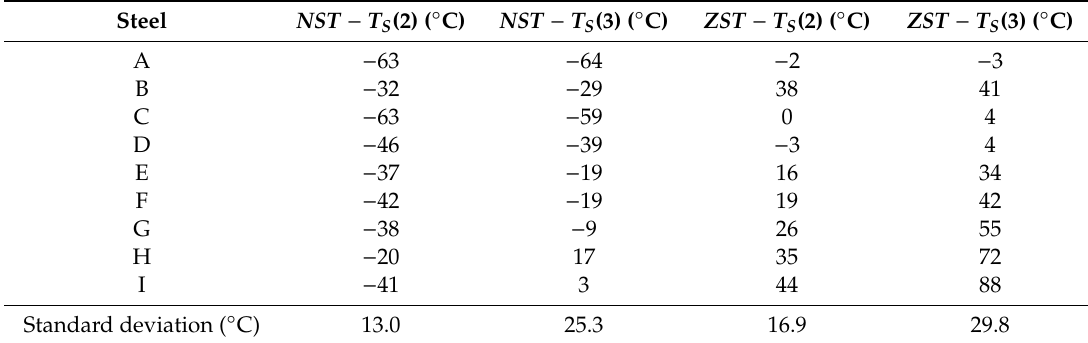
Table 4. Di ff erences between determined nil-strength temperatures, zero strength temperatures and solidus temperatures of the investigated